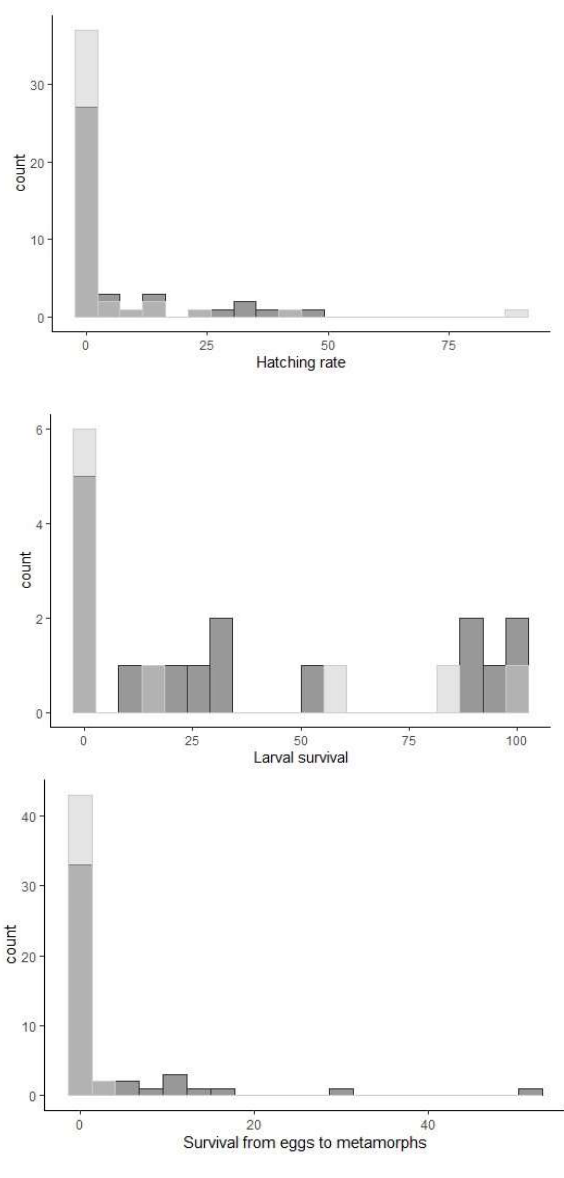
Annex 4: Distribution of hatching rate , survival rate during larval stage and survival rate from eggs to metamorphs of spring cohorts, in presence (dark grey) or absence (light grey) of older tadpoles laid in